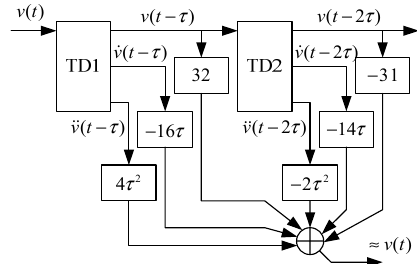
Figure 16. Block diagram of compensation Equation